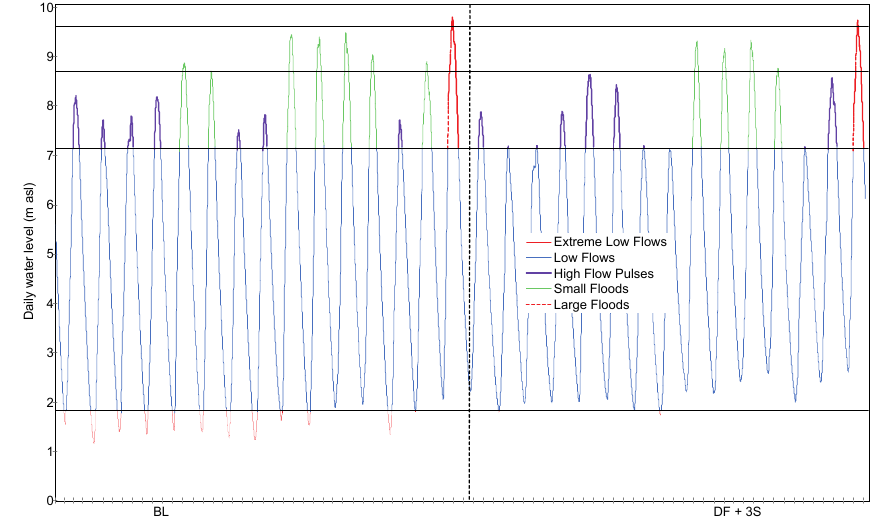
Figure 5. Comparison of daily water levels and environmental flow components between the baseline scenario (BL) and the combined effect of the definite future and the 3S hydropower scenarios (DF + 3S).